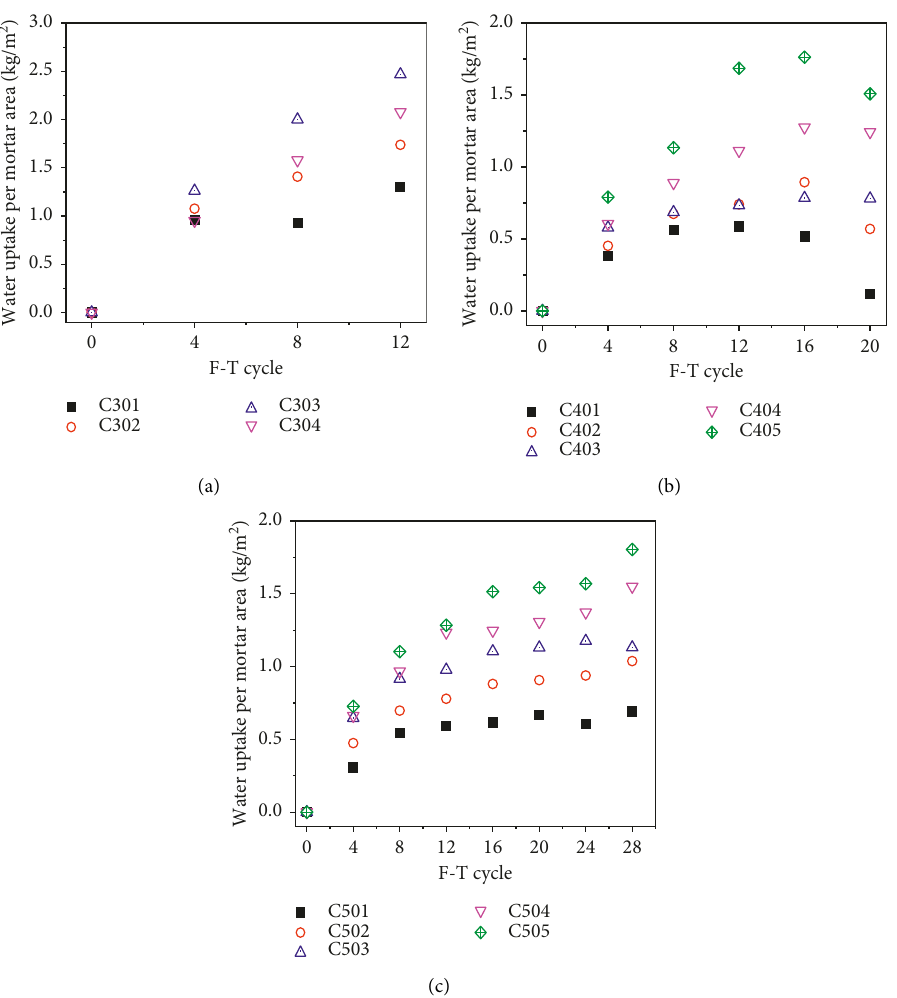
Figure 8: Water absorption of unit mortar area at 28d curing